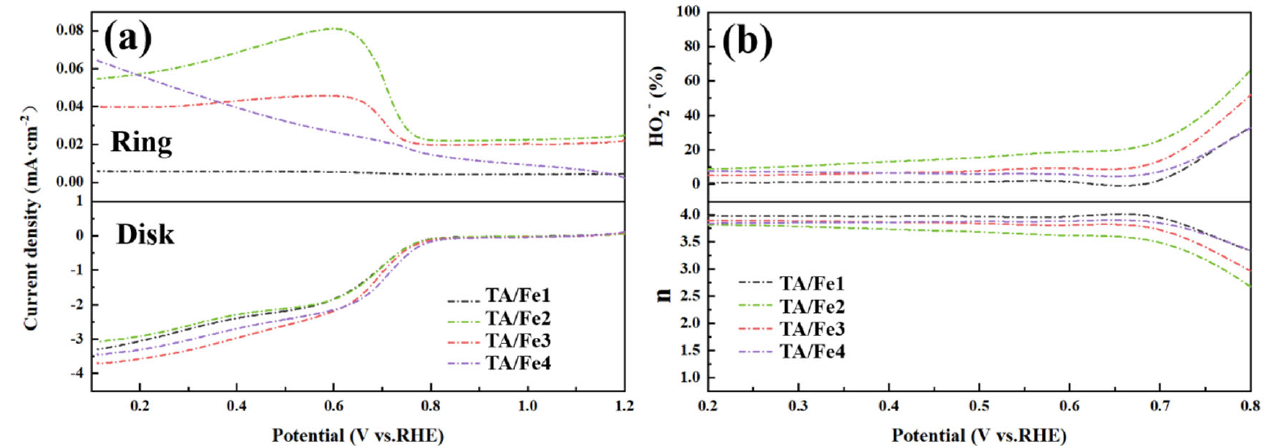
Figure 11. ( a ) Potentiostatic polarization curves and ( b ) hydrogen peroxide yields and transfer number of the as ‐ prepared aerogel catalysts (at the constant voltage of 1.3 V vs. RHE). Table 3. ORR catalytic performance data of the as ‐ prepared aerogels. Sample